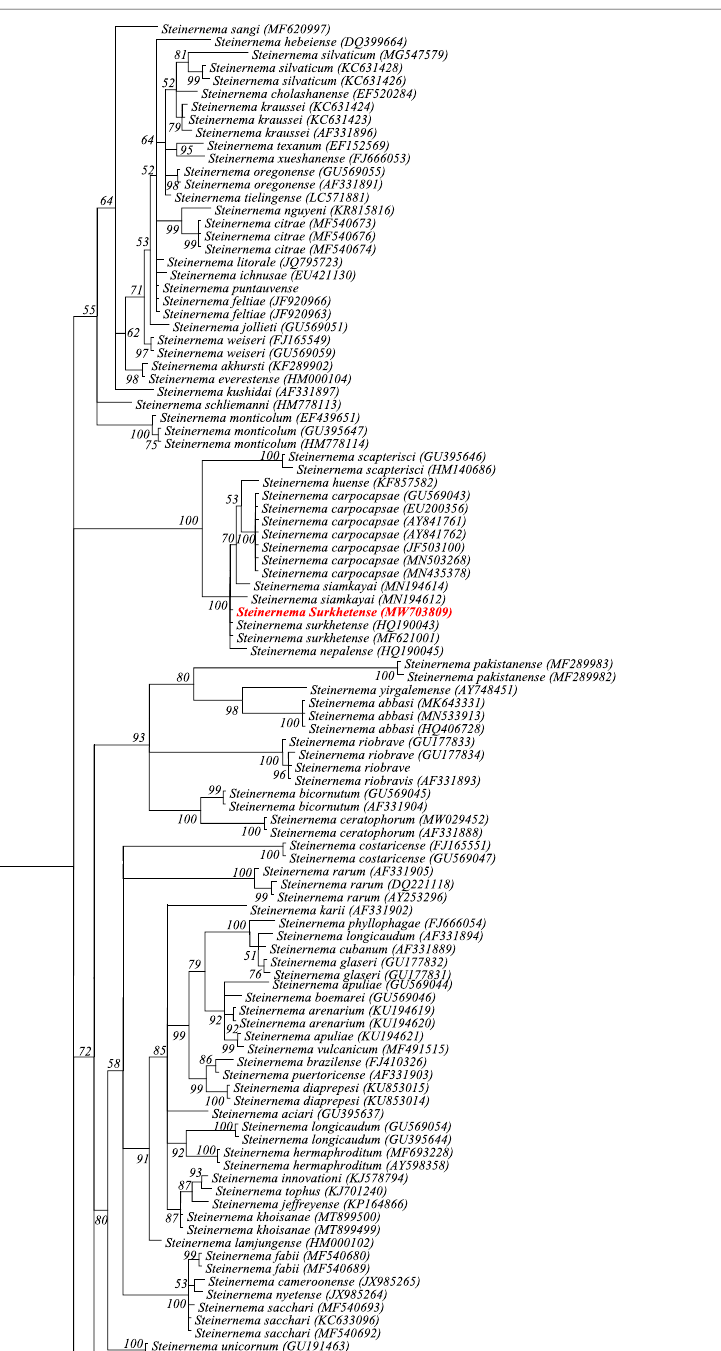
G I. Bayesian posterior probabilities (in percentage) are + +